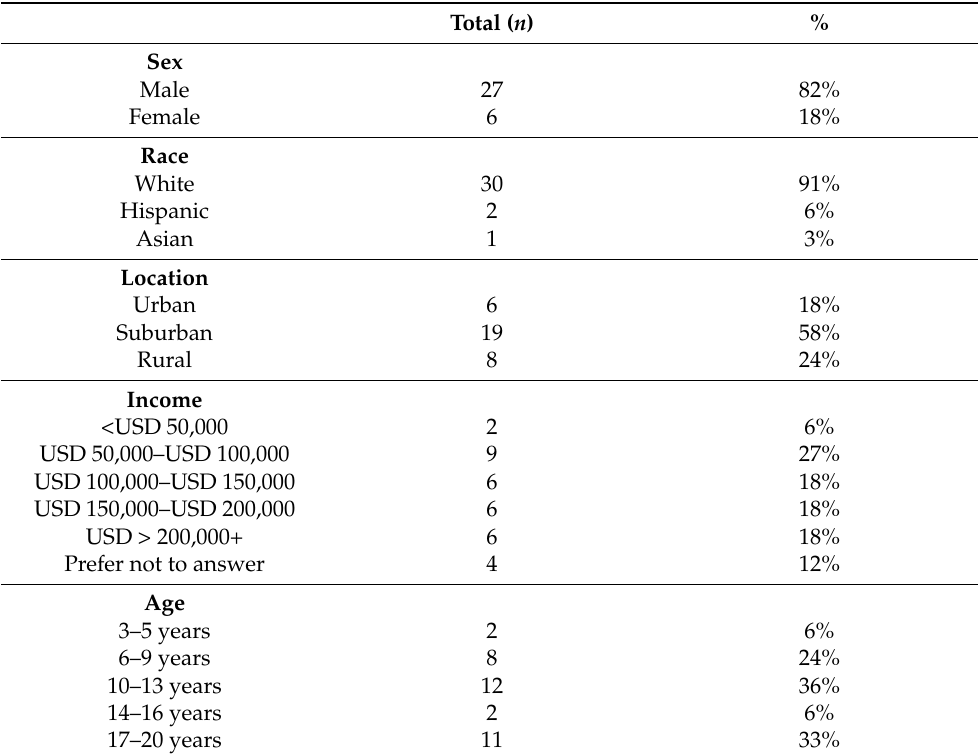
Table 1. Demographic information for children with FXS